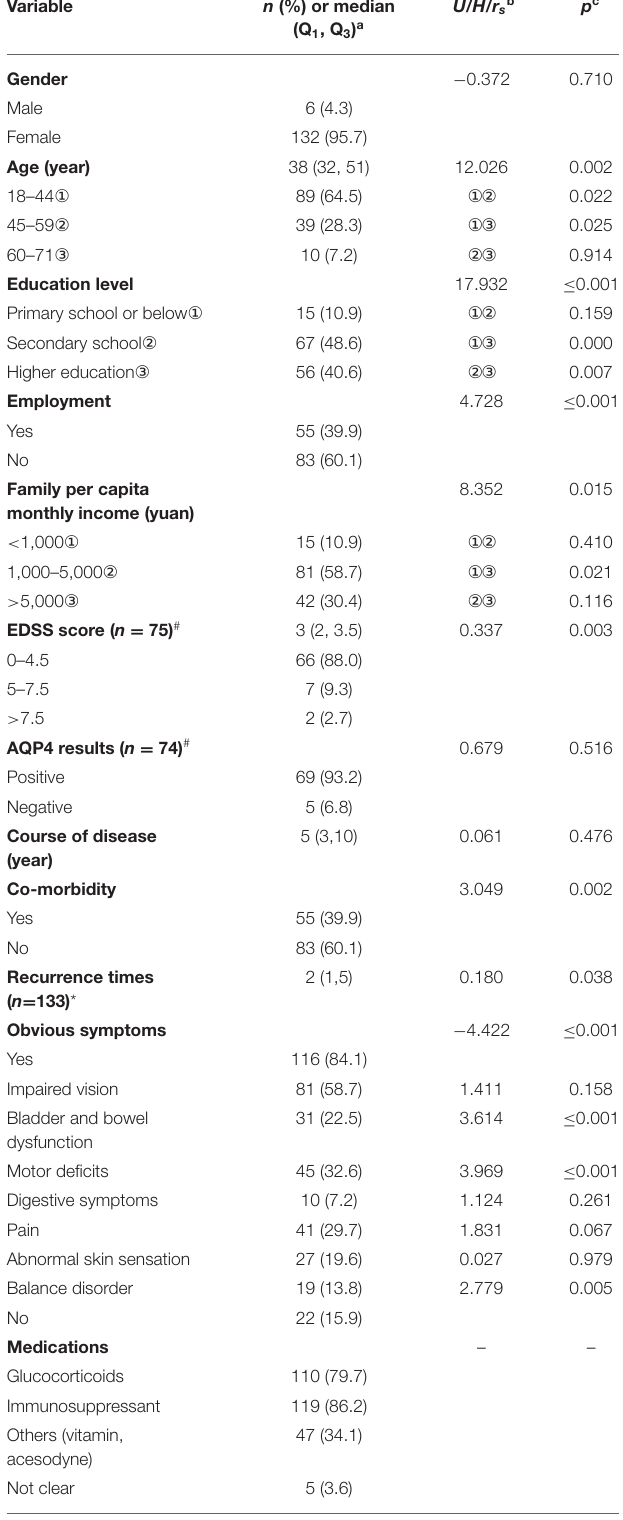
TABLE 1 | Characteristics of the respondents and the results of univariate analyses ( N = 138).